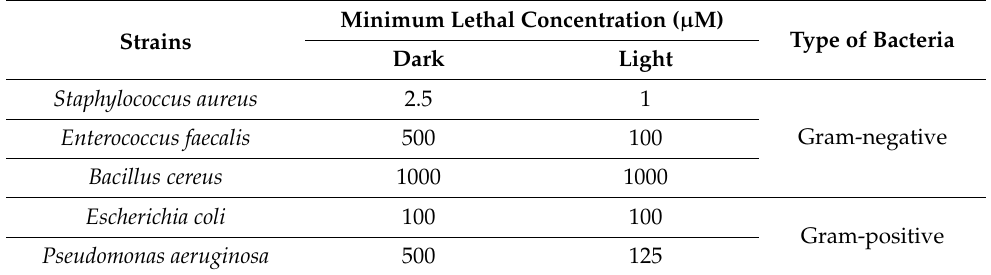
Table 2. Phototoxicity of methylene blue against typical types of pathogenic bacteria 1 .